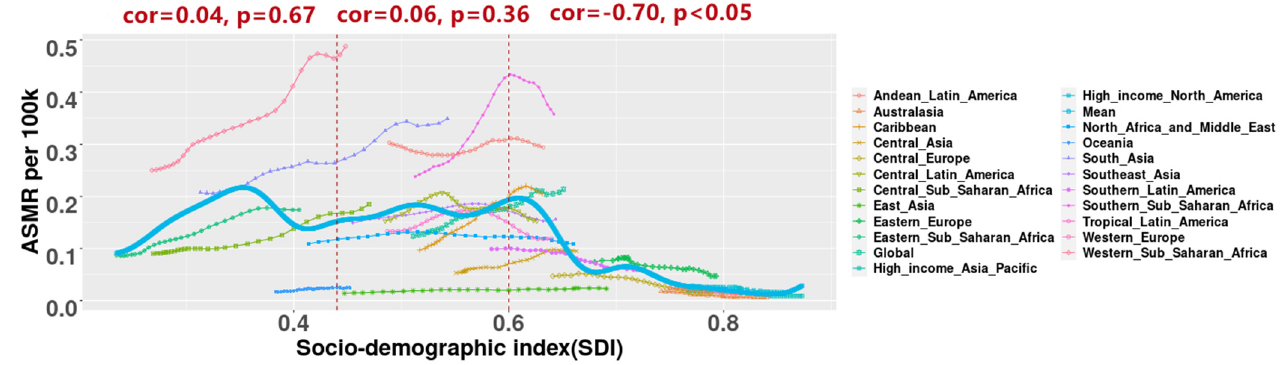
Figure 2. Age-standardized mortality rates (ASMR) of PM2.5-related neonatal infections globally and in 21 regions in 1990–2019. The expected value is represented by the solid blue line. The ASMR of PM2.5-related neonatal infections in four regions (South Asia, Southern Sub-Saharan Africa, Western Sub-Saharan Africa, and Andean Latin America) were obviously higher than the expected value.